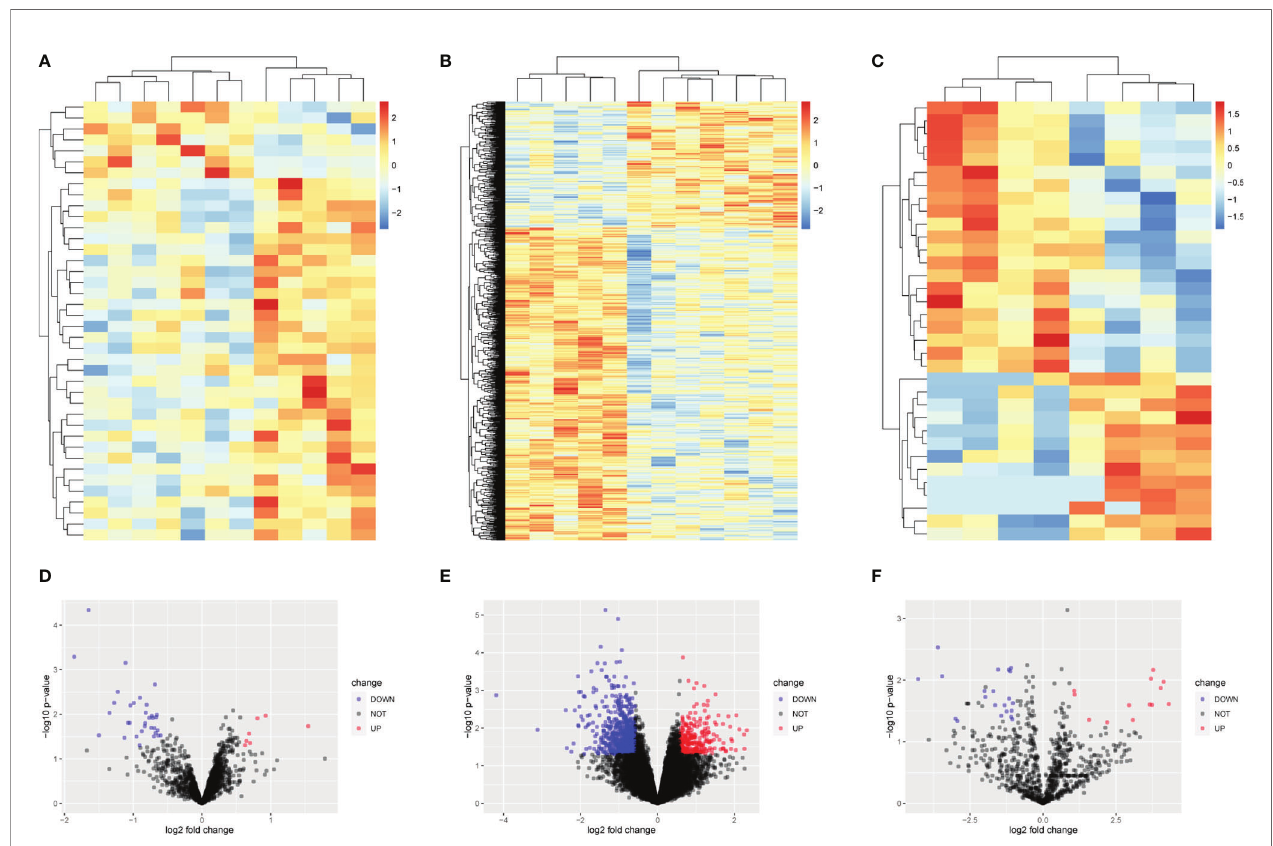
FIGURE 1 | Heatmap and volcano plot of differentially expressed lncRNAs, mRNAs, and microRNAs. (A) Heatmap of 7 upregulated and 33 downregulated lncRNAs. (B) Heatmap of 243 upregulated and 604 downregulated MRNAs. (C) Heatmap of 13 upregulated and 21 downregulated lncRNAs. (D) Volcano plot of 7 upregulated and 33 downregulated lncRNAs. (E) Volcano plot of 243 upregulated and 604 downregulated mRNAs. (F) Volcano plot of 13 upregulated and 21 downregulated